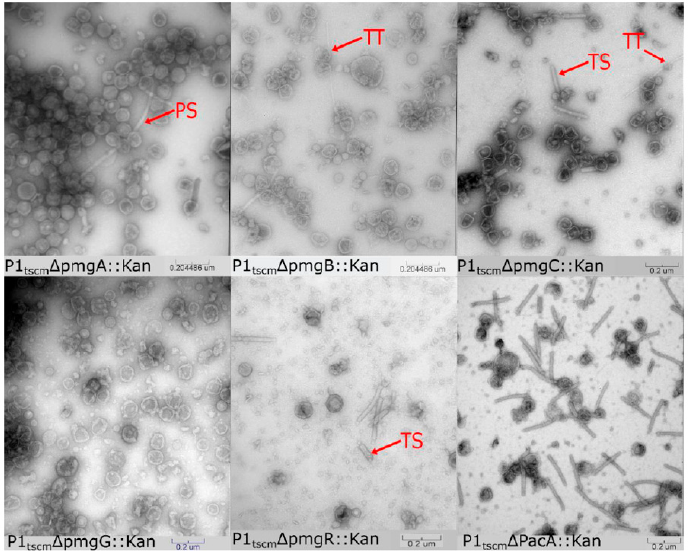
Figure 2. Transmission electron micrographs of CsCl step-gradient purified P1 morphogenic gene knockouts and parental P1. PS is polysheath, TT is tail tube, and TS is truncated sheath.